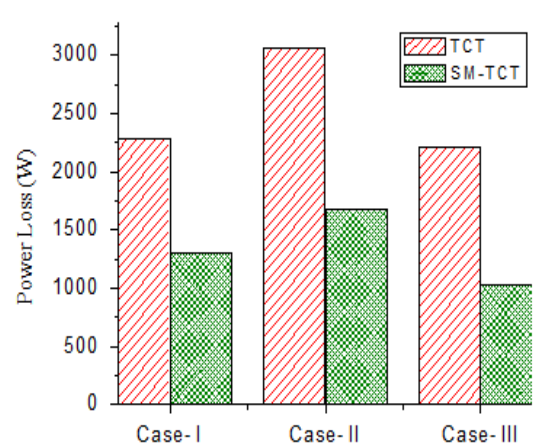
Figure 6(a)-(c) Obtained I–V curves for the shading cases: I- III